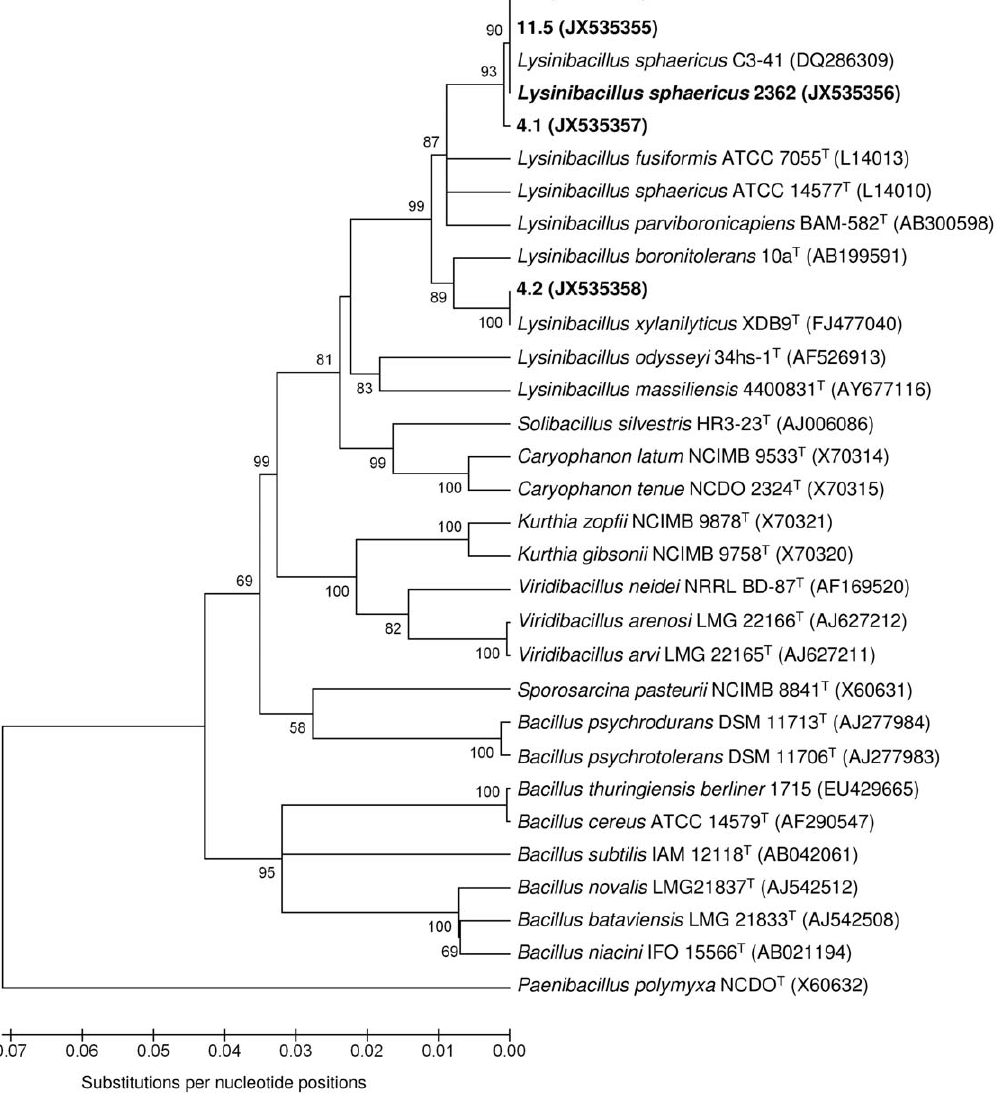
Figure S1 Percentage of water samples positive for Lysinibacillus sphaericus (A) and Bacillus thuringiensis israelensis (B). Black: percentage of positive samples with concentrations above LOQ; grey: positive samples with concen- trations below LOQ that were removed from the statistical analysis. (TIF)